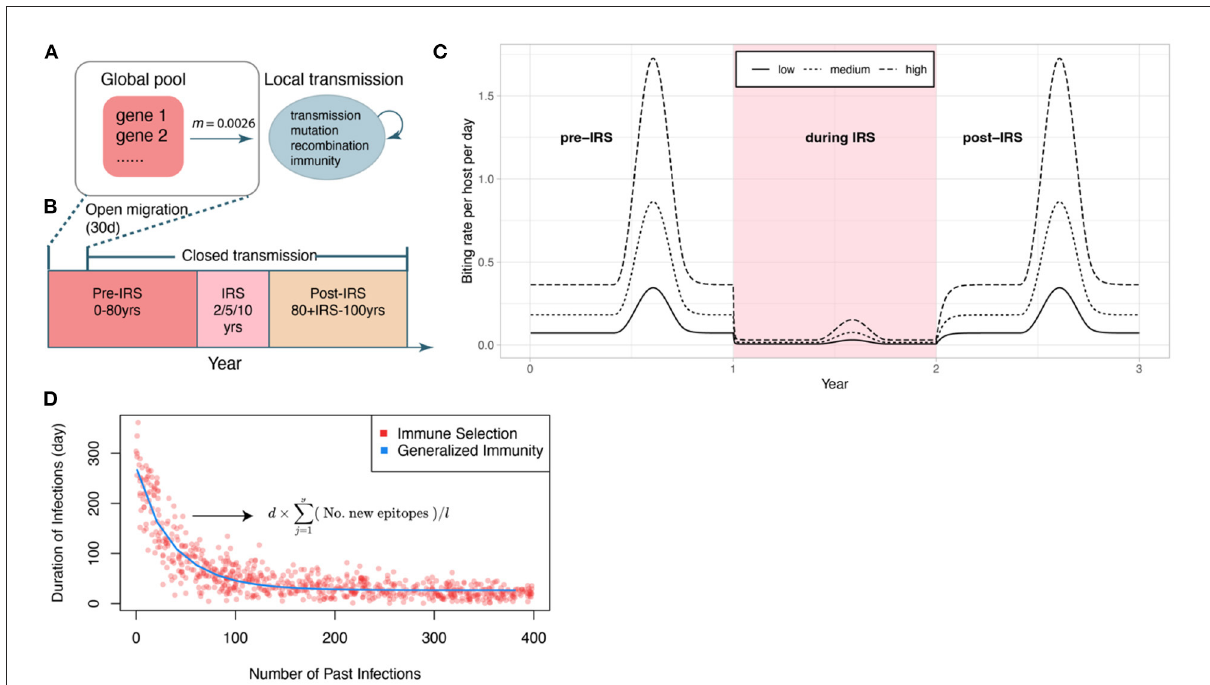
FIGURE1 Schematic of the IRS experiment design. (A) Initial transmission events and migrant genomes in a local population (blue circle) are sourced from a global pool of genes (red square) (see Methods). The value of the migration rate is inferred from an empirical dataset for a high transmission region in Ghana (see Methods). Individual infections are tracked locally. We also track events of transmission, mutation of genes, recombination within and between genomes, and acquisition and loss of specific immune memory in hosts. (B) The period of open migration from the global pool lasts for 30 days to initialize the system. Each simulation follows three stages (after a burn-in period): a pre-IRS period during which the transmission in the local population reaches a stable state; an IRS period of 2, 5, or 10 years reducing transmission, and a post-IRS period when transmission rates go back to pre-IRS levels. (C) Three levels of transmission intensity (biting rates) are explored in the experiments (pre-/post-IRS, low: 44 bites per host per year; medium: 110 bites/h/y; high: 221 bites/h/y). (D) The two regimes (with and without NFDS) are ensured to be comparable by specifying the average duration of infection as a function of the number of previous infections in G with a curve fitted to the points generated under S. The expression for the duration of infection under S is given here, and its explanation can be found in the methods